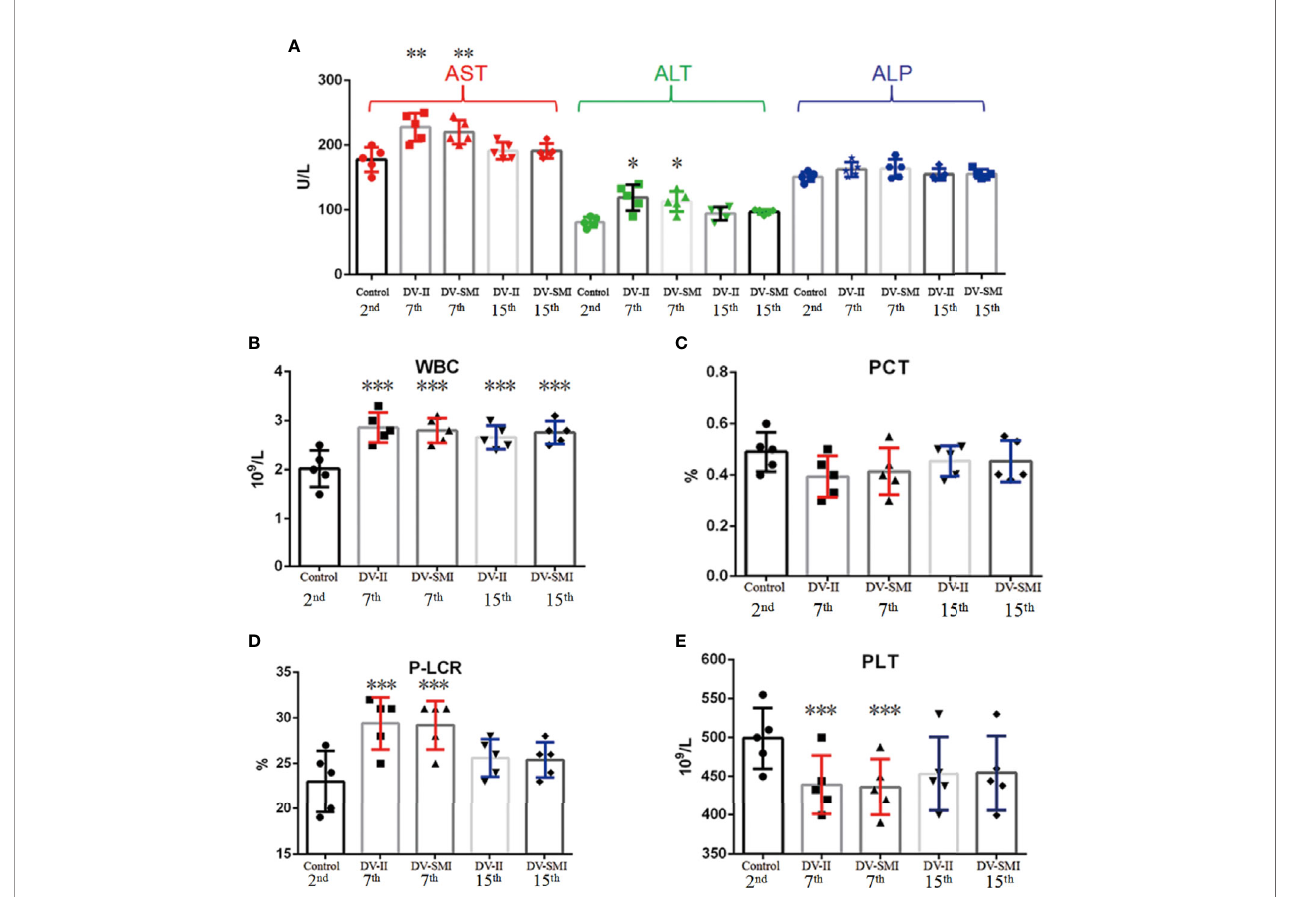
FIGURE 3 | Hematological analysis and concentration of liver enzymes in the blood of DENV-2 and DENV-3-inoculated tree shrew (n = 9 per group). (A) The biochemical indicators AST, ALT and ALP on the different time periods early (2nd d), middle (7th d) and later (15th d) after injection. (B – E) The blood tests for WBC, PCT, P-LCR and PLT on the different time periods early (2nd d), middle (7th d) and later (15th d) after injection. *P <0.05, **P